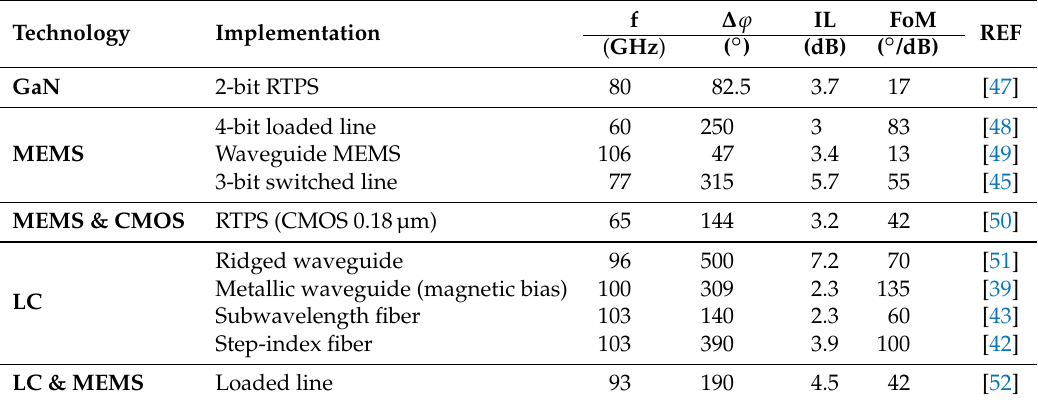
Table 3. Comparison of different phase shifter technologies at